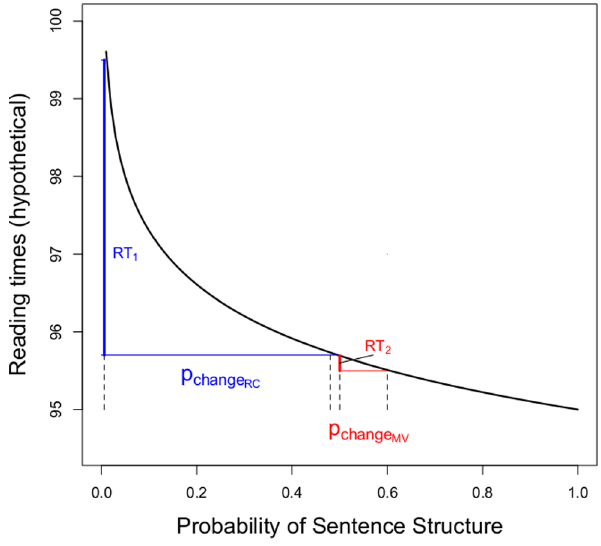
Figure 2. Relationship between reading times and linguistic probabilities. Illustration of the log-linear relationship between reading times and linguistic probabilities, following Smith and Levy (2013). We indicate the changes in probabilities (horizontal lines) for relative clauses (RCs; blue) and main verbs (MVs; red) for Experiment 1 and indicate the predicted changes in reading times for both (vertical lines).